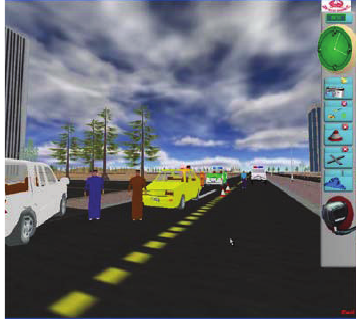
Figure 6: A serious game for tra ffi c accident investigators